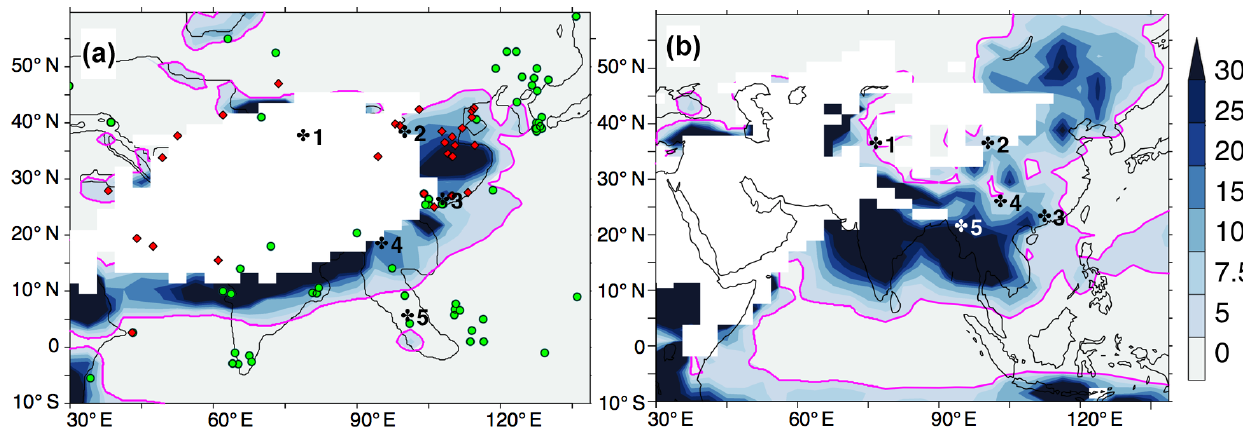
Figure 10. The 3W / 3D ratio for the (a) EOC4X and (b) control simulations. Regions receiving less than 1mmd − 1 are kept blank. Overlaid magenta outline corresponds to the value 3W / 3D = 5, considered as minimum value in modern monsoonal regions. We also highlight evaporite (red diamonds) and coal deposits (green circles) from Boucot et al. (2013), as well as the five highlighted regions described in the